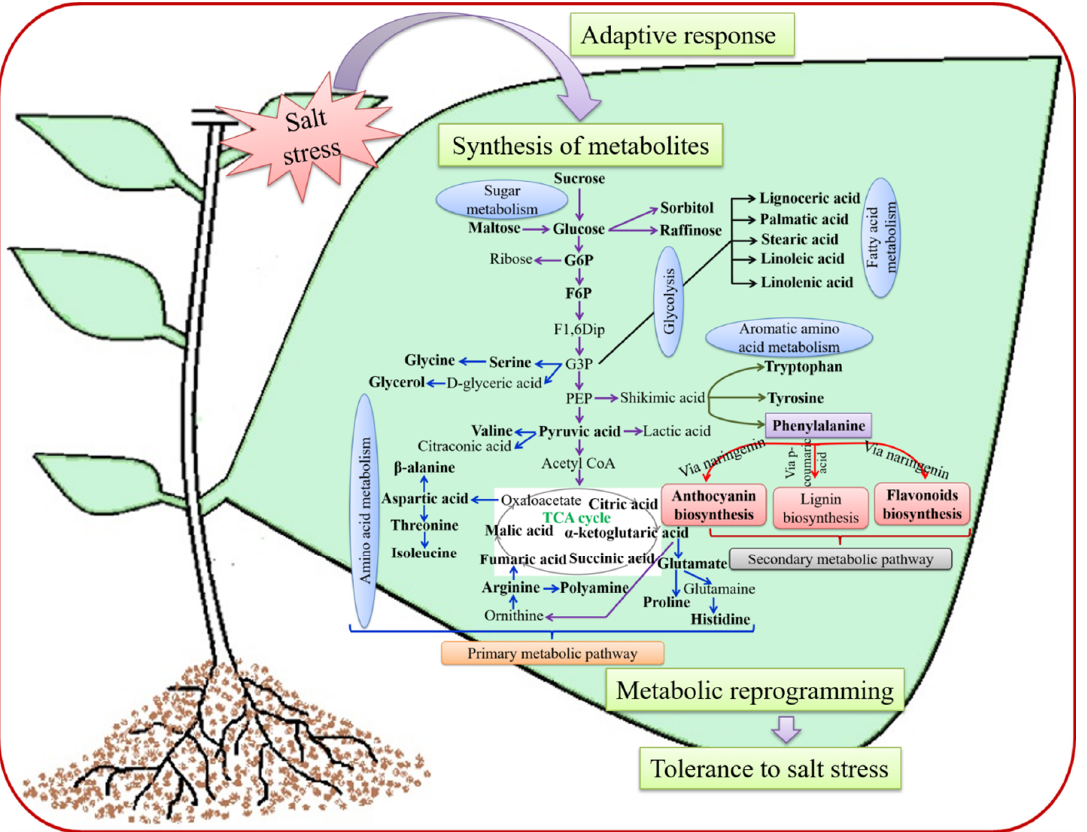
Figure 1. A simplified model of metabolic reprogramming in plants under salt stress. When plants sense high salinity, they undergo a metabolic reprogramming that involves changes of primary and secondary metabolites for maintaining appropriate osmotic homeostasis and activation of signaling pathways. This is the simplest strategy that plants use to acclimate to survive under salt stress. The bold metabolites are discussed in the text and they have important roles during salt tolerance. Purple arrows, sugar metabolism; blue arrows, amino acid metabolism; olive green arrows, aromatic amino acid metabolism; black arrows, fatty acid metabolism; red arrows, secondary metabolic pathways. F6P, fructose 6-phosphate; F1,6Dip, fructose 1,6-diphosphate; G6P, glucose 6-phosphate; G3P, glyceraldehyde 3-phosphate; PEP, phosphoenolpyruvate; TCA, tricarboxylic acid.